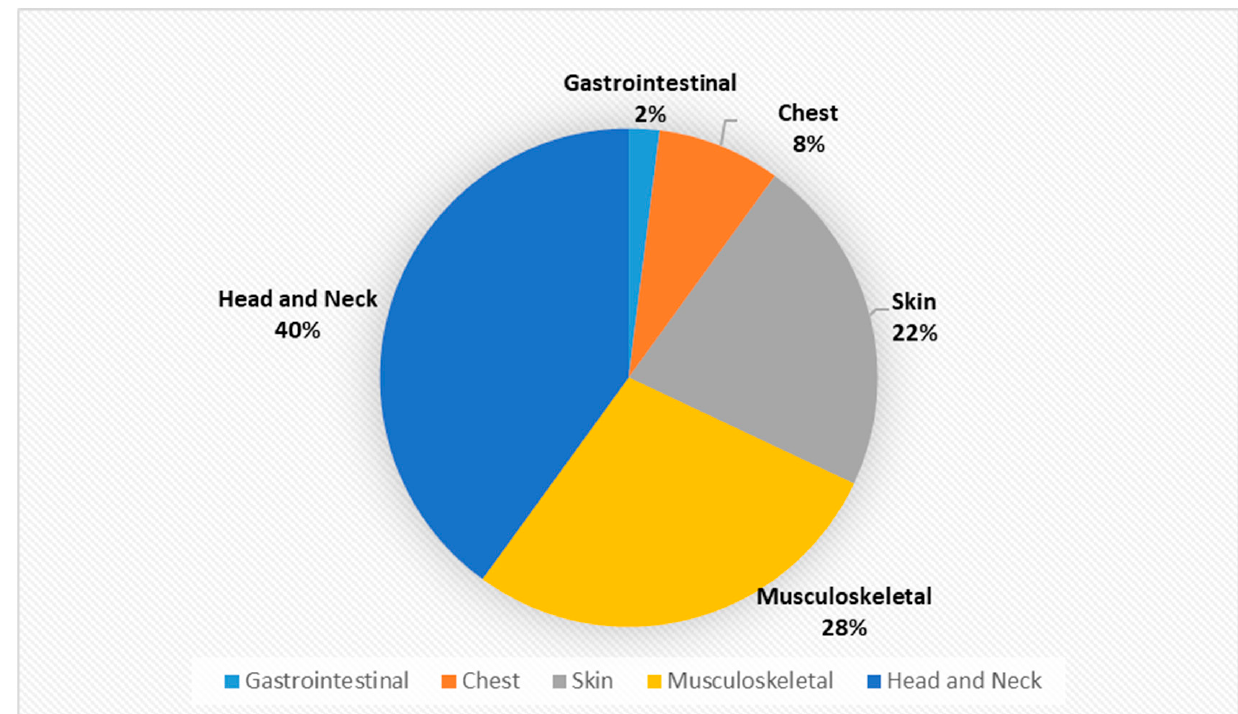
Figure 1. Epidemiology of injuries associated with IPV as a % ( n = 144).